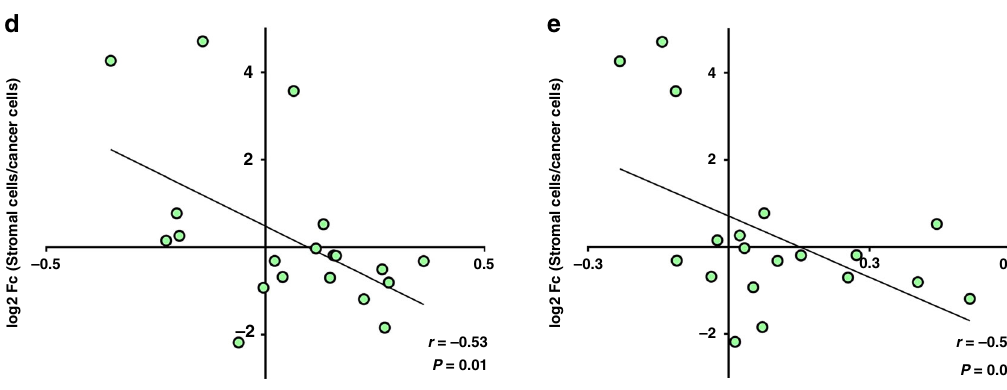
Fig. 5 Other circRNAs without miR-7 binding sites also correlate with miR-7 target genes. a NanoString nCounter expression analyses of 11 circRNAs in fractions of stromal and cancer cells isolated by laser capture microdissection of colon cancer tissues, pooled from four individual representative patient samples ( n = 1). b , c Scatter plots showing log2 fold changes in stromal-to-cancer cell ratios ( y -axis) and correlation with the stromal cell-enriched circRNAs, circFBXW7 ( b ) and circCCDC66 ( c ) ( x -axis), for each of the 20 miR-7 target genes with corresponding linear regression statistics and Pearson correlation coef fi cient (r). d , e Scatter plots showing log2 fold changes in stromal-to-cancer cell ratios ( y -axis) and correlation with the cancer cell-enriched circRNAs, circZKSCAN1 ( d ) and circZNF91 ( e ) ( x -axis), for each of the 20 miR-7 target genes, with corresponding linear regression statistics, employing an F test to investigate if the slope was signi fi cantly non-zero, and Pearson correlation coef fi cient ( r ). Correction for multiple testing was not